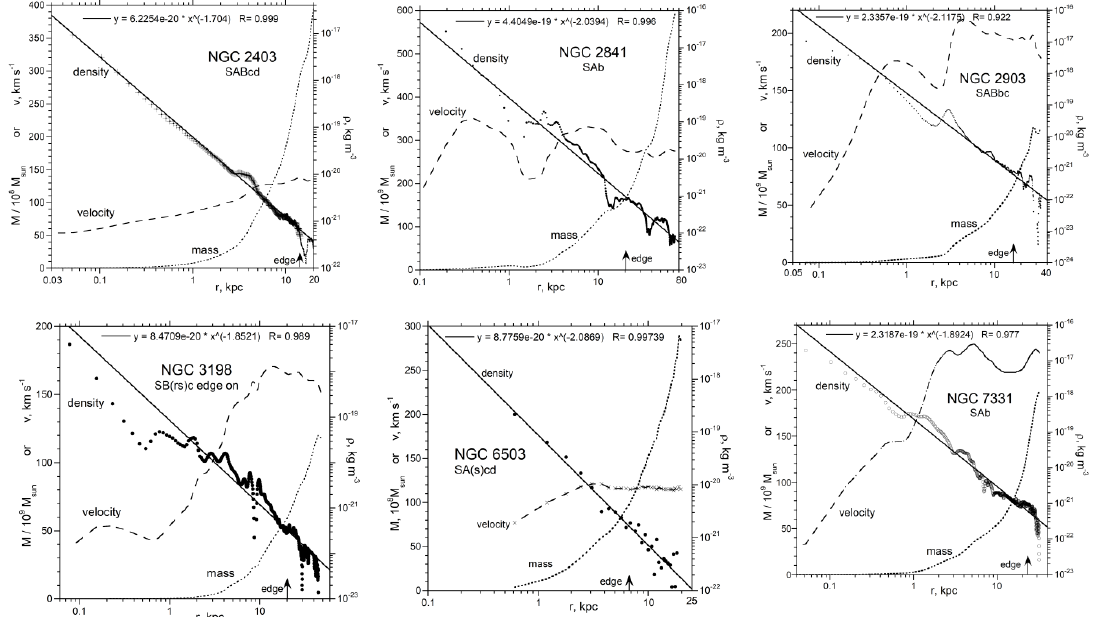
Figure A4. High-velocity large spirals from the compilation of Bottema and Pestaña [64]. Inner densities for similar visible edges depend on velocities.